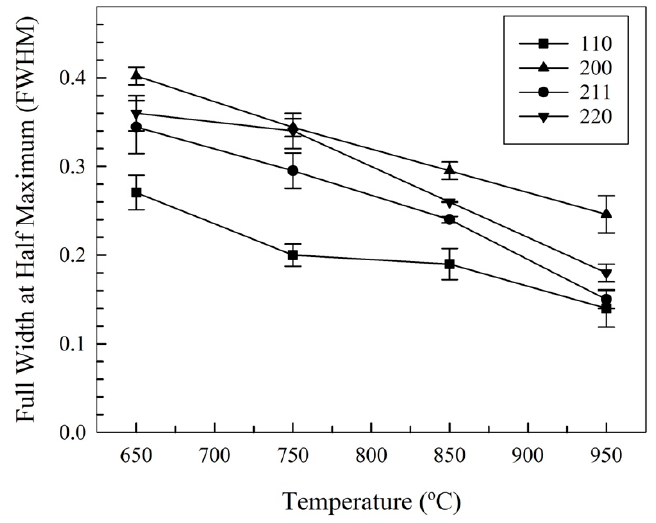
Figure 6. FWHM for different diffraction planes corresponding to the sample with 20% strain annealed for 60 min.